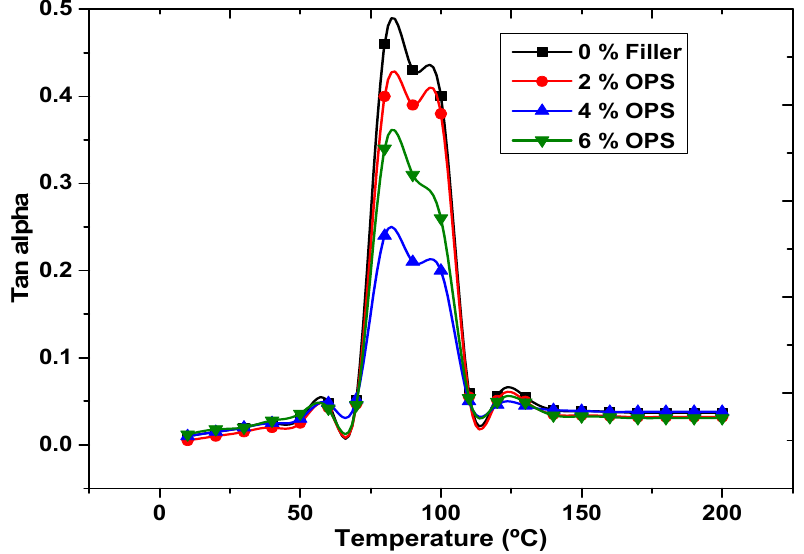
Figure 10. The effectiveness of OPS nanofiller content on the flax/epoxy-based hybrid composites on the damping factor.